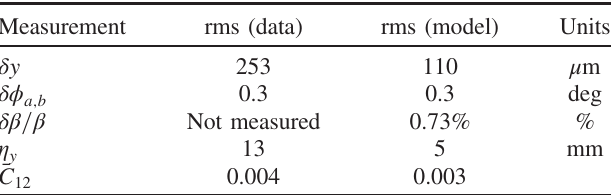
TABLE II. Typical levels of correction for optics measurement after the full emittance tuning procedure. Measurements were taken at 0.8 mA ( 1 . 3 × 10 10 = bunch). Root mean square devia- tions from the design are reported for both the machine measurement and a model of the machine that is fit to the measurements. Beta beat is computed from fitting phase